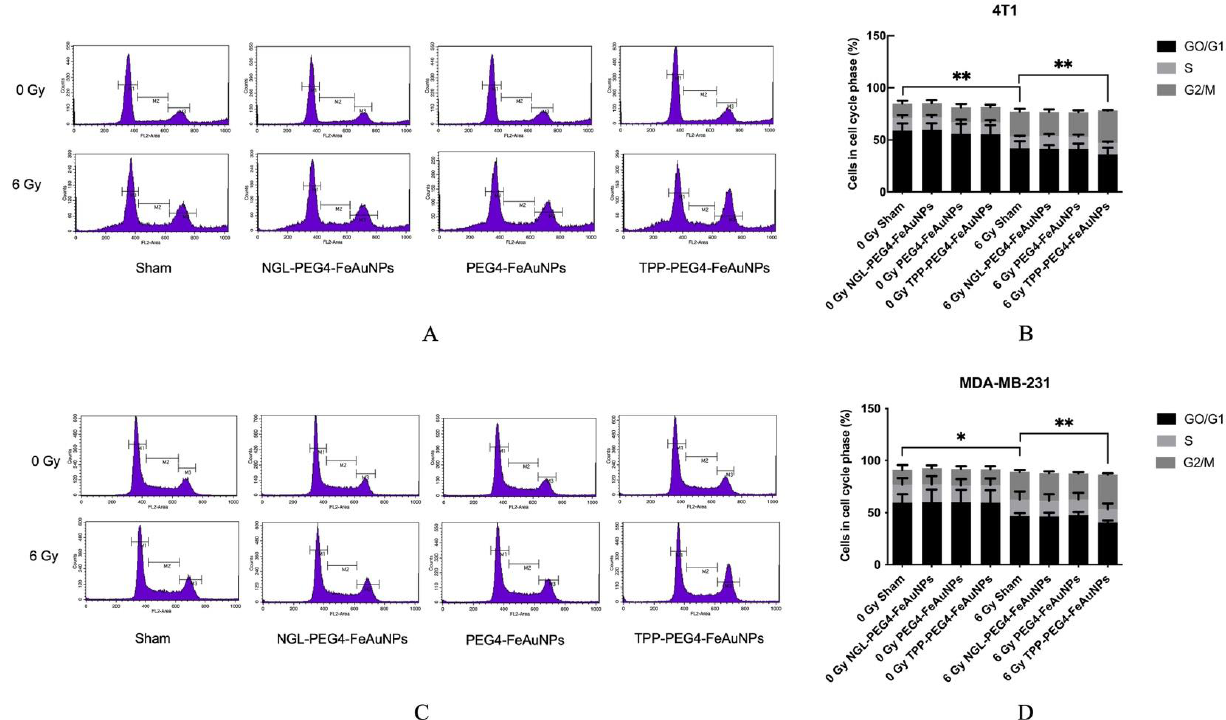
Figure 5. Cell cycle analysis of 4T1 ( A , B ) and MDA-MB-231 ( C , D ) TNBC cells after treatment with NGL-PEG4-FeAuNPs, PEG4-FeAuNPs or TPP-PEG4-FeAuNPs for 24 h followed by an irradiation with 6 Gy. TPP-PEG4-FeAuNPs induce significant cell cycle arrest at the G2/M checkpoint. Cell cycle distribution was measured in permeabilized cells by flow cytometry. Significance: * p ≤ 0.05, ** p ≤ 0.01; results represent mean values ± SD of 3 independent